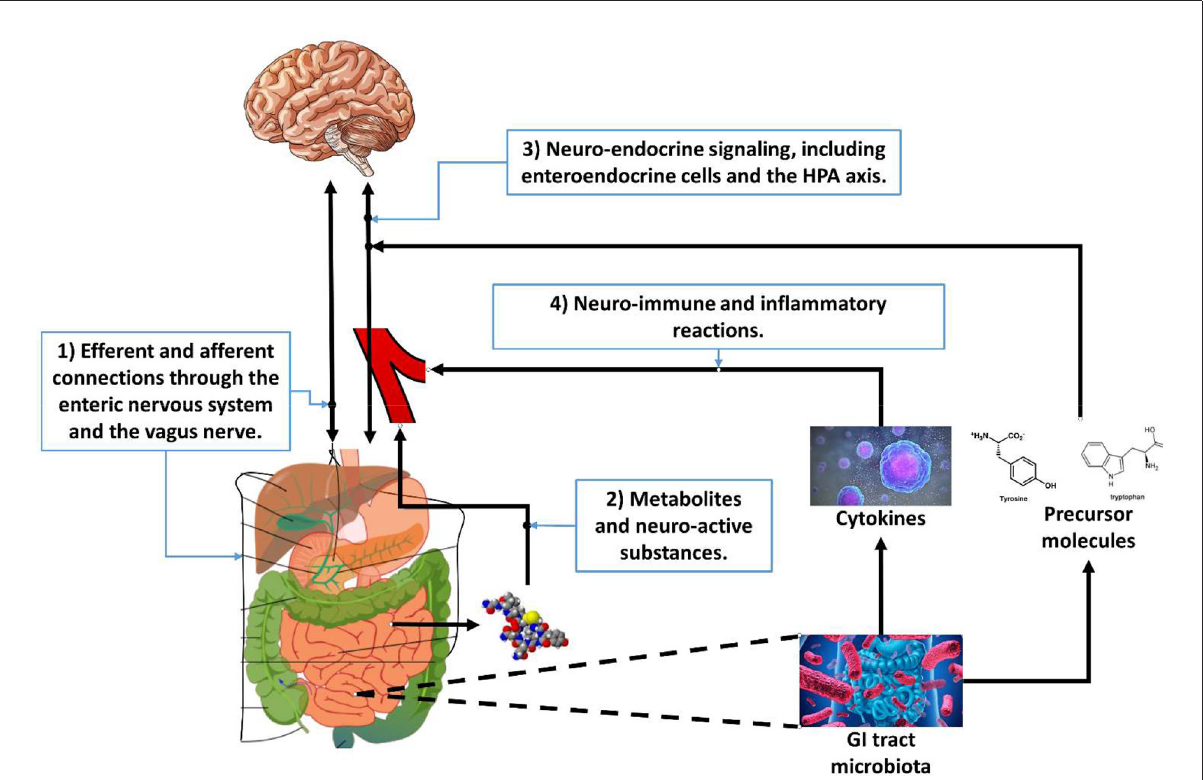
FIGURE1 The four pathways of the microbiota-gut-brain axis relevant for gastrointestinal tract-based implicit